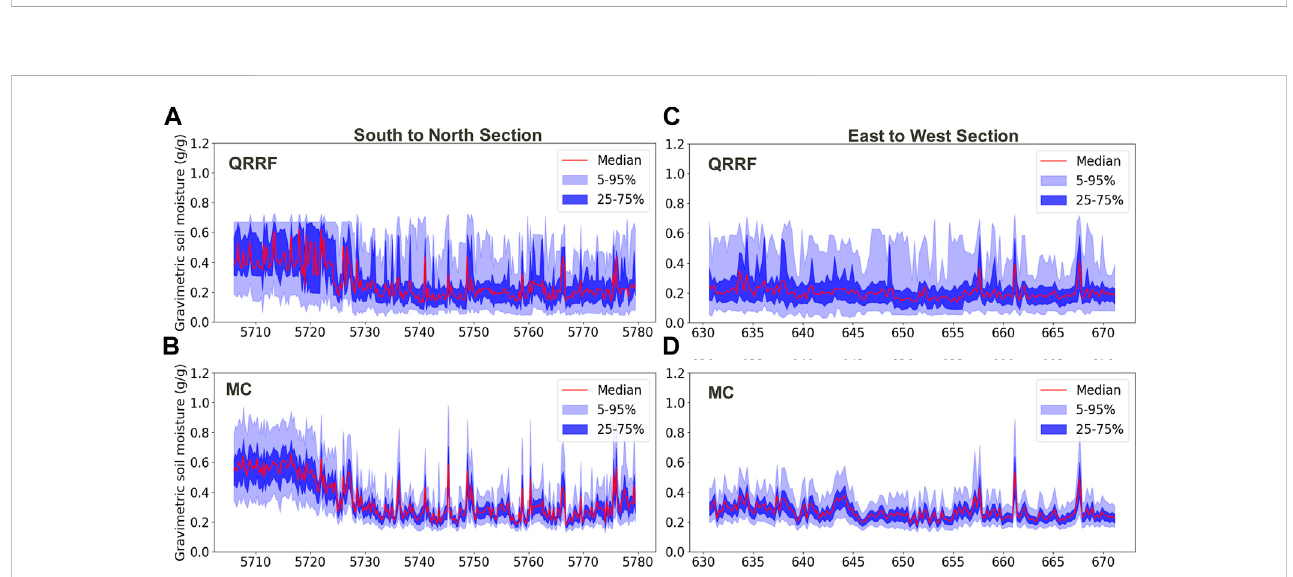
FIGURE 14 Soil moisture mean prediction and fi fth, 25 th , 75 th , and 95 th percentiles along the centered south/north section [ (A) QRRF and (B) MC] and the centered west/east section [ (C) QRRF and (D)